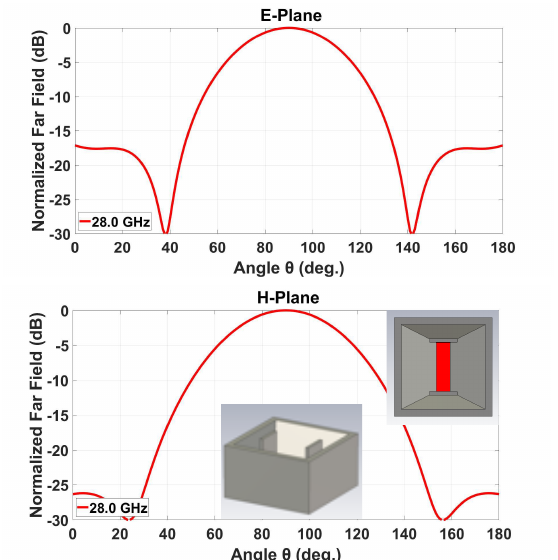
Figure 6. Simulated radiation patterns of single modified horn element with inserted pair of metal chips in both principal planes: ( top ) E-plane perpendicular to slot alignment; and ( bottom ) H-plane parallel to slot alignment. Horn schematics (two views) are shown as inset diagrams.